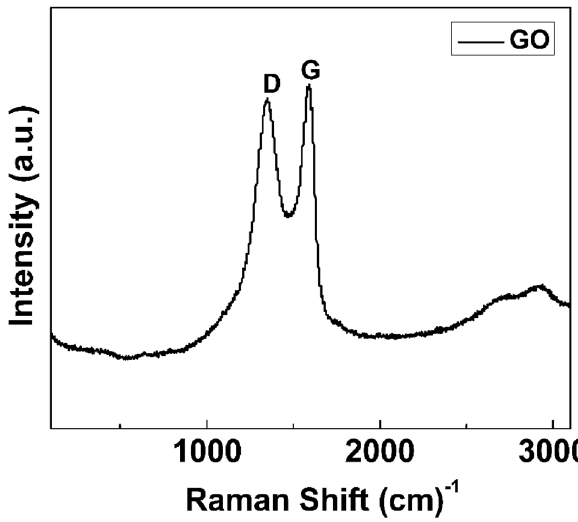
Fig. 6 Raman spectrum of graphene